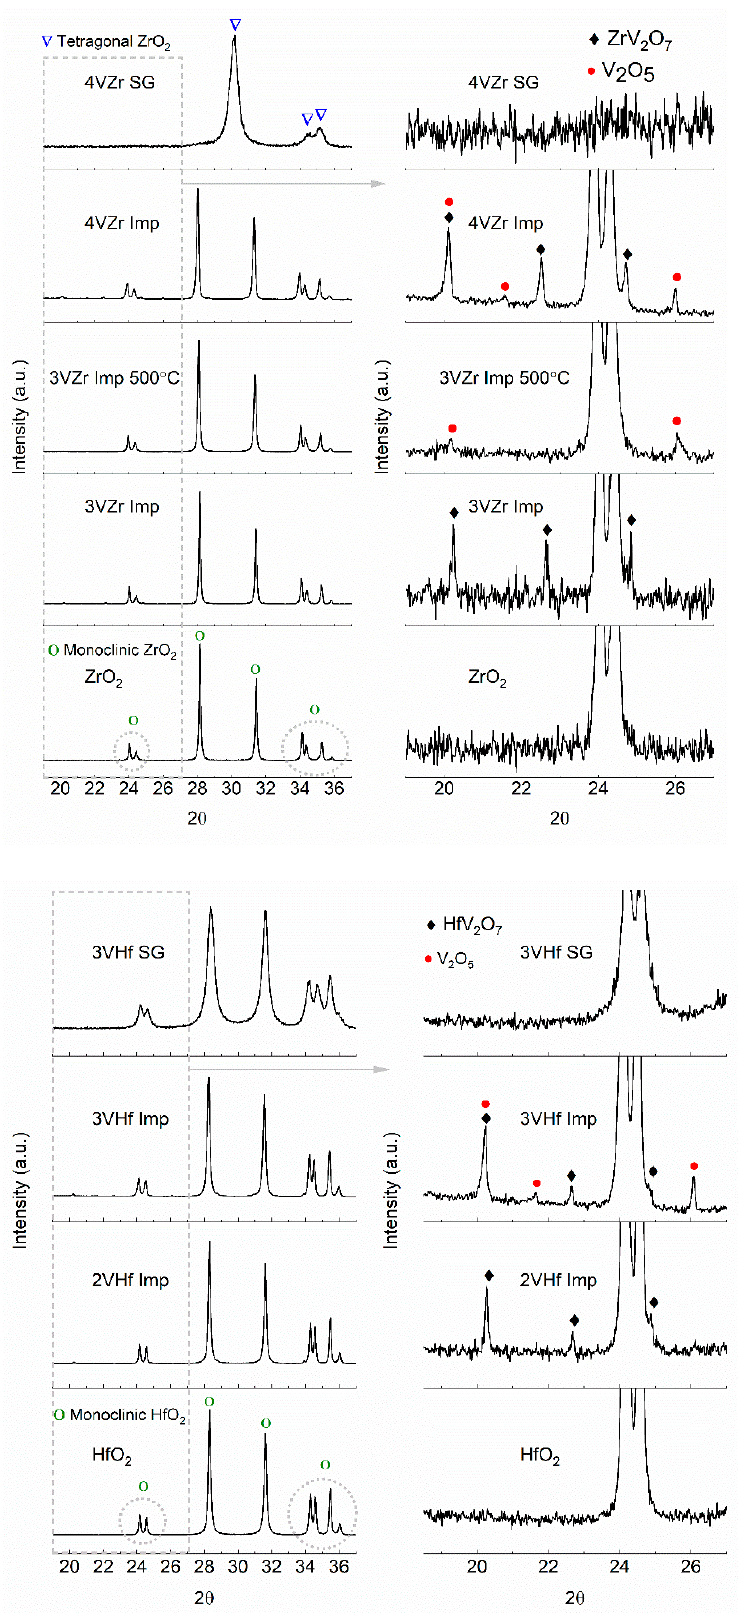
Figure 1. XRD diffractograms for impregnated and sol–gel prepared VZr and VHf catalysts.